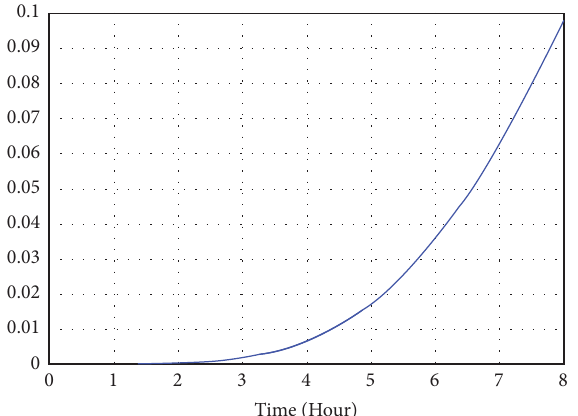
Figure 4: HEP based on the stress of workers when there is no rest time or lunch hour.